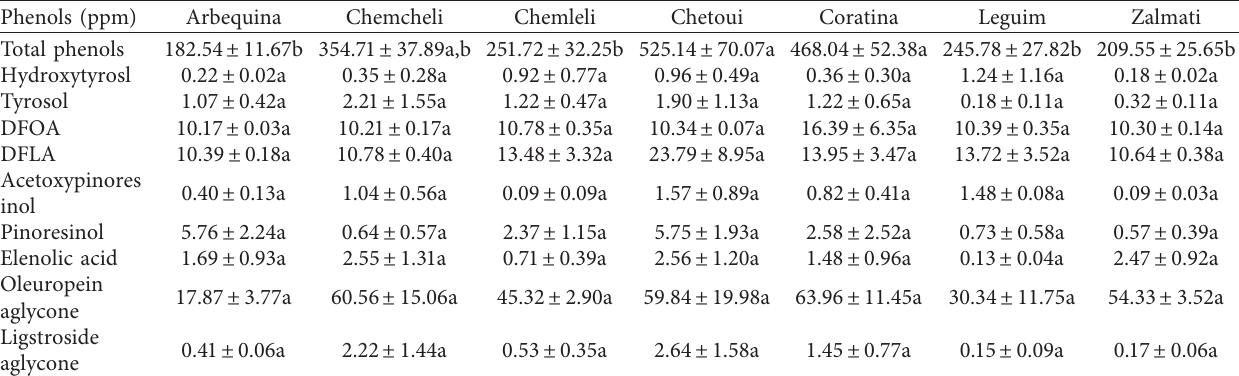
Table 5: Phenolic composition of the seven VOOs.